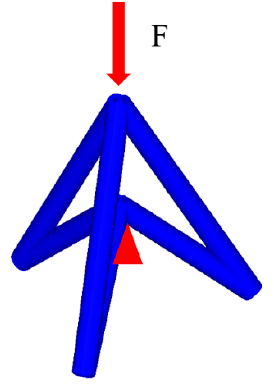
Figure 4. The model of unit cell analysis.